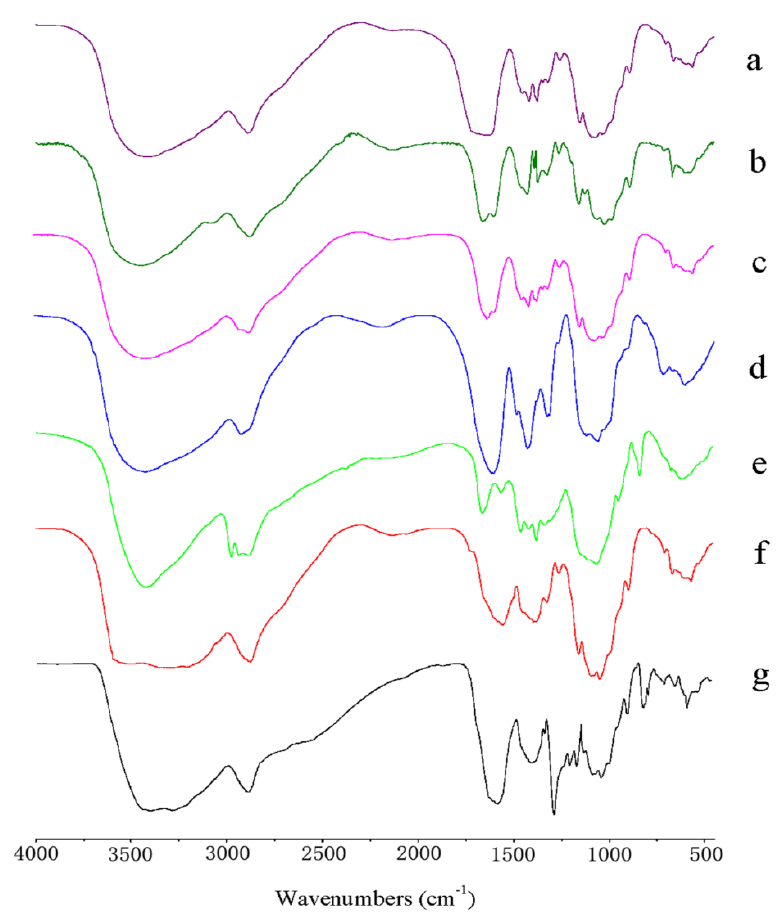
Figure 2. FTIR spectra of: (a) chitin; (b) CS-D3; (c) CS-M1; (d) CS-S1; (e) CS-S2; (f) CS-A2; (g) CS-A3.